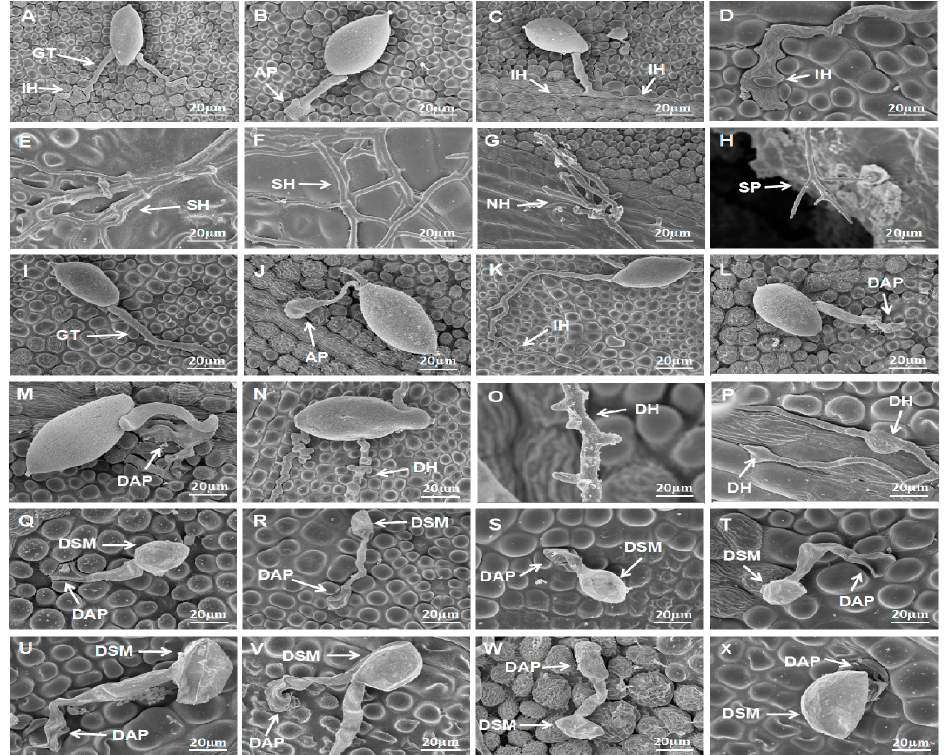
Figure 5. Effect of S. fimicarius BWL-H1 volatiles in P. litchii infection process. Inoculation of P.